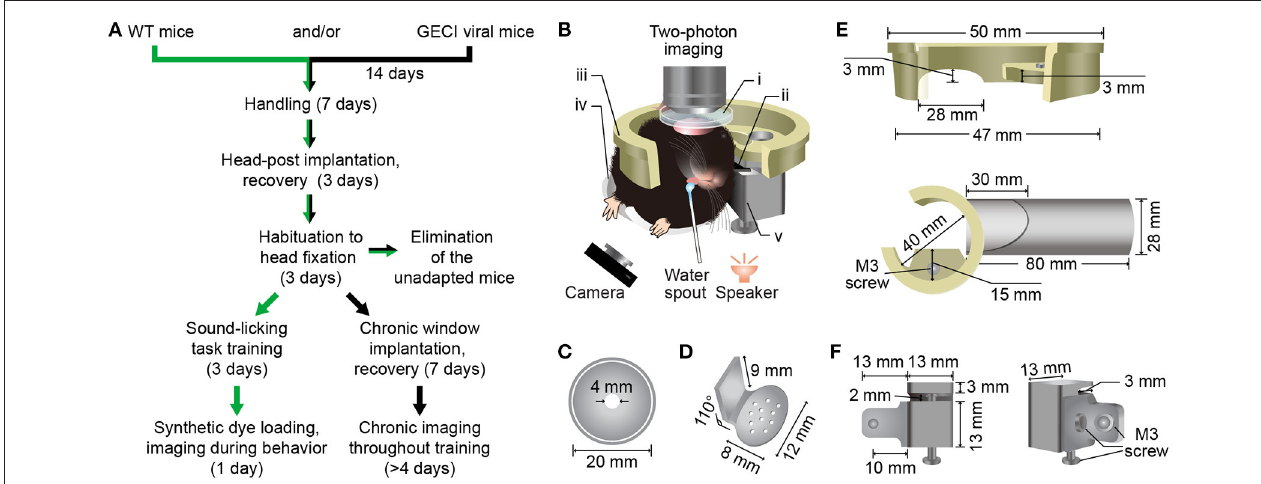
FIGURE 1 | Protocol and custom-made head fixation apparatus for two-photon Ca 2 + imaging in the Au1 of behaving mice. (A) Technical flowchart for two-photon imaging during a sound-triggered licking task. Green or black arrows indicates the route for imaging with synthetic Ca 2 + indicators or genetically encoded Ca 2 + indicators, respectively. (B) A schematic diagram of a mouse in custom-made head fixation apparatus, performing two-photon imaging during sound-triggered licking task (side view). The speaker was placed at 6cm below the left ear of mouse and the camera was monitoring the licking behavior at infrared mode. i, Recording chamber (C) ; ii, Head-post (D) ; iii, Recording holder ( E , upper); iv, Body tube ( E , lower); v, Head-post holder: (F) . The detailed design and size of these parts are present below. (C) Plastic recording chamber (upper view). The chamber was fit for both electrophysiology and two-photon recording. (D) Titanium head-post for head fixation. Consist of two parts with an angle of 110 ◦ The lower part has a suitable radian for fitting the skull and several built-in holes for spreading of glue. Another part fits the head-post holder. (E) Resinous recording holder connecting the head-fixation apparatus and the microscope. The upper panel shows the fine design fitting the custom-made slot on the objective table of the microscope. The lower shows the connection of the holder and the plastic body tube. The upper part of tube was cut off for unhindered body. The lower part was kept for front paws. (F) Head-post holder (stainless steel) was the connective piece for connecting the recording holder, head-post and the body tube with three M3 screws. It consists of two parts. The left part connecting the body tube and the right part connecting recording holder and head-post (left).